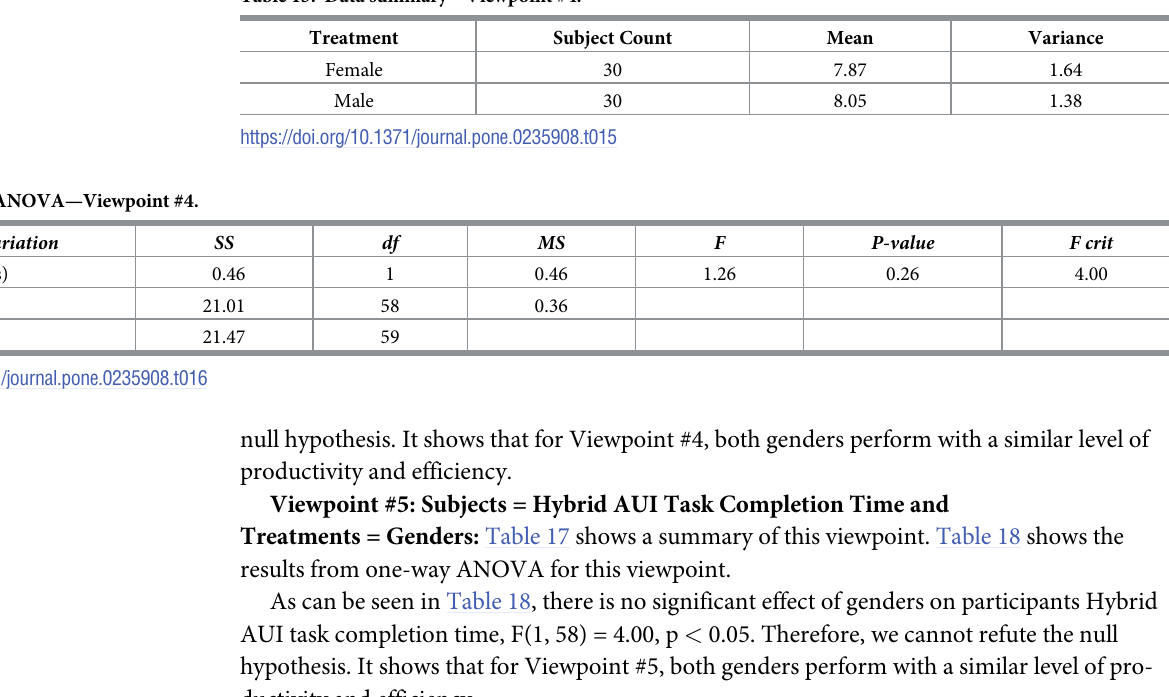
Table 15. Data summary—Viewpoint #4.